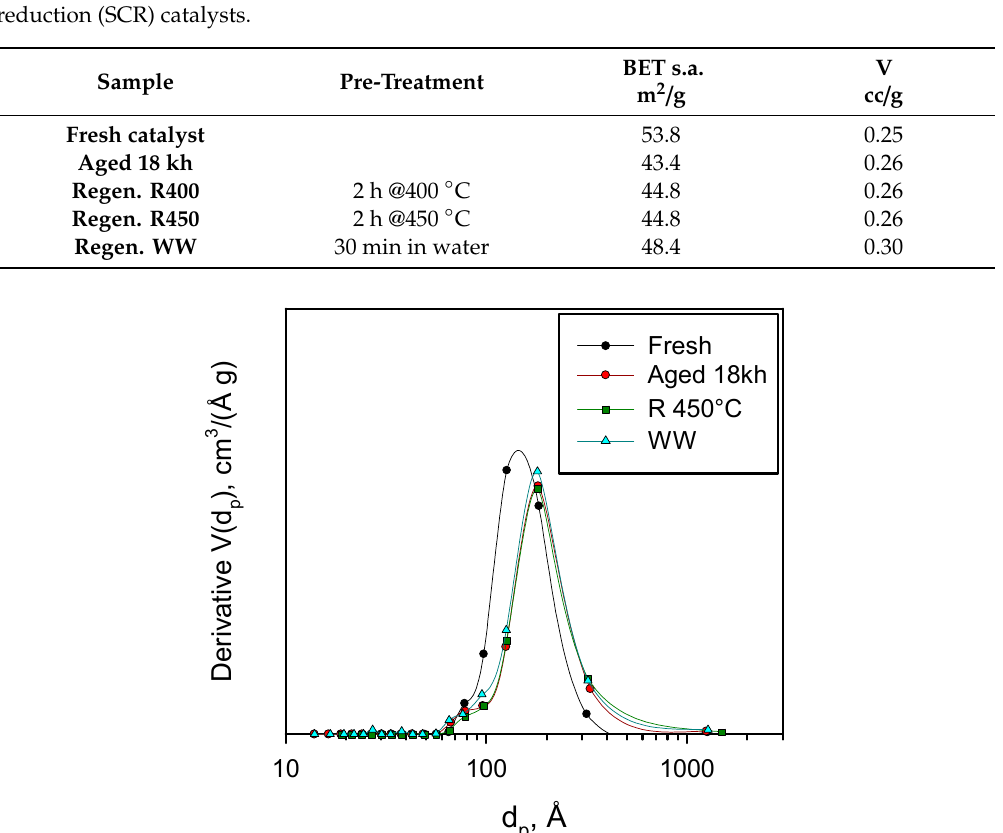
Table 1. Chemical composition of the fresh catalyst by XRF analysis.